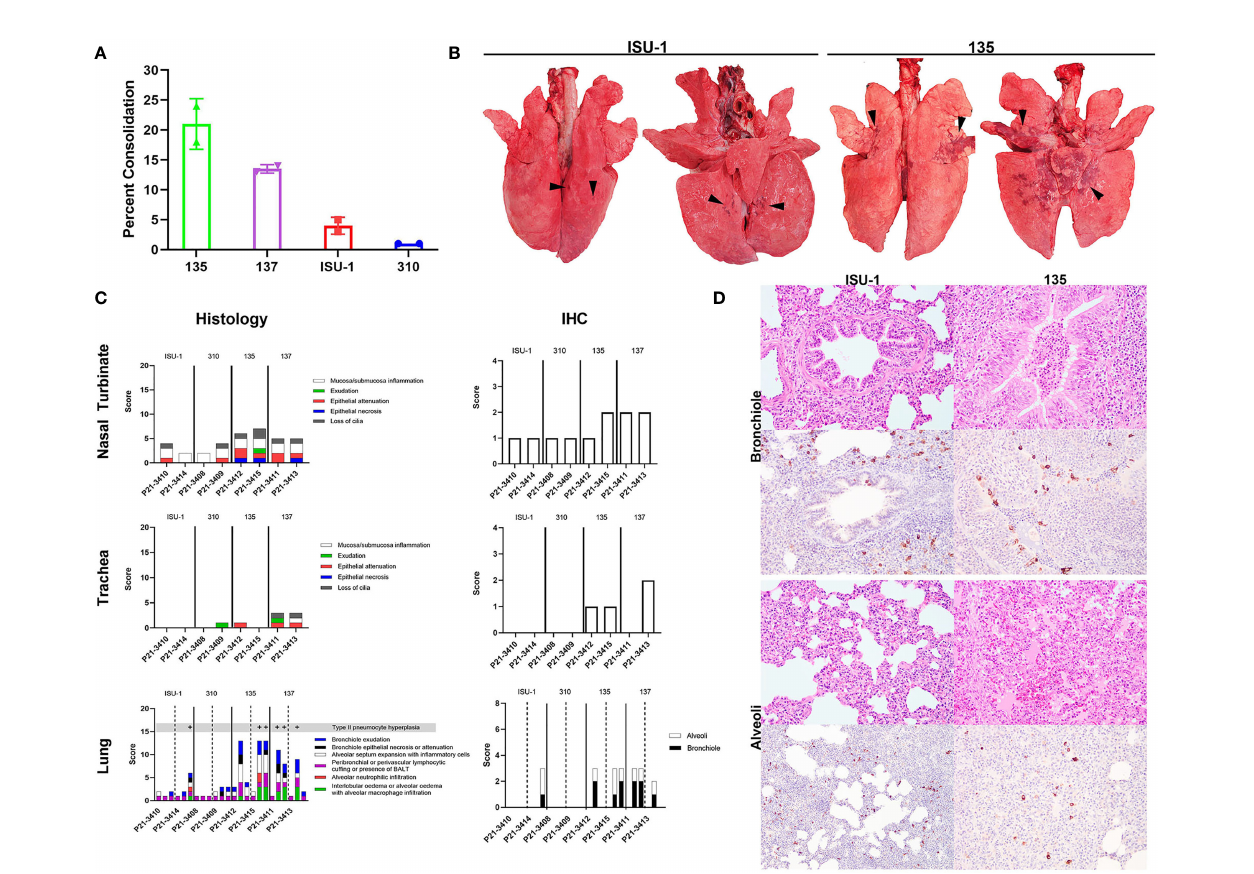
FIGURE 3 | Lung pathology following in vivo challenge with PRCV strains 135, 137, ISU-1 and 310. Percent area of lung consolidation (A) . Representative gross pulmonary pathology images for pigs infected with either ISU-1 or 135 (B) . Arrowheads indicate areas of consolidation. Images are dorsal and ventral views. Histopathology and immunohistochemical scores for nasal turbinate, trachea, and lung (C) . Representative histopathology and immunohistochemical (IHC) images of the lung (D) . There was only subtle bronchiolar epithelium hyperplasia and association of rare infected bronchiolar epithelium in ISU-1 pig. The bronchiole lumen was fi lled with neutrophils in 135 infected pig. The alveolar wall of ISU-1 was mildly expanded with in fl ammatory cells. In the 135 pig, there was multifocal pulmonary oedema and alveolar macrophages, and infrequently intra-alveolar haemorrhage. The N labelled cells within the alveoli were predominantly type II pneumocytes and intra-vascular macrophages, and a small fraction of type I pneumocytes. Images were taken at 200x magni fi